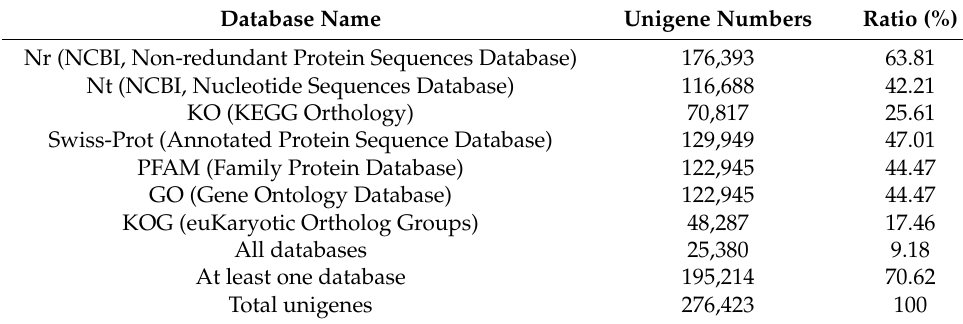
Table 2. Unigenes of N. tangutorum were compared with seven databases.